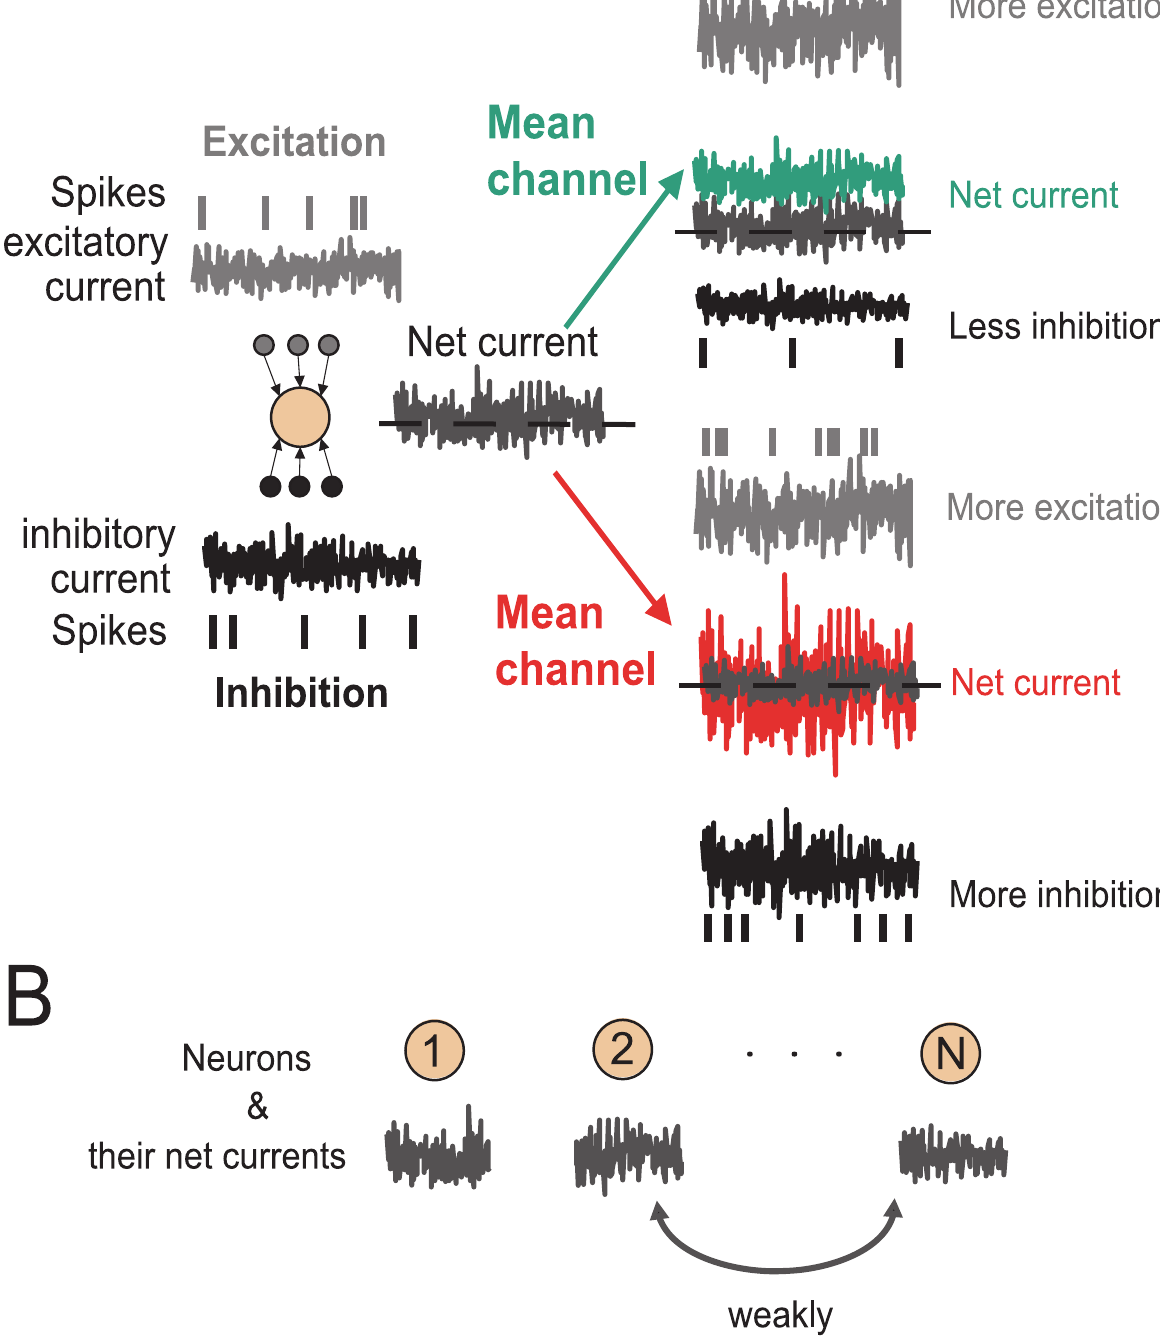
PLoS Computational Biology |